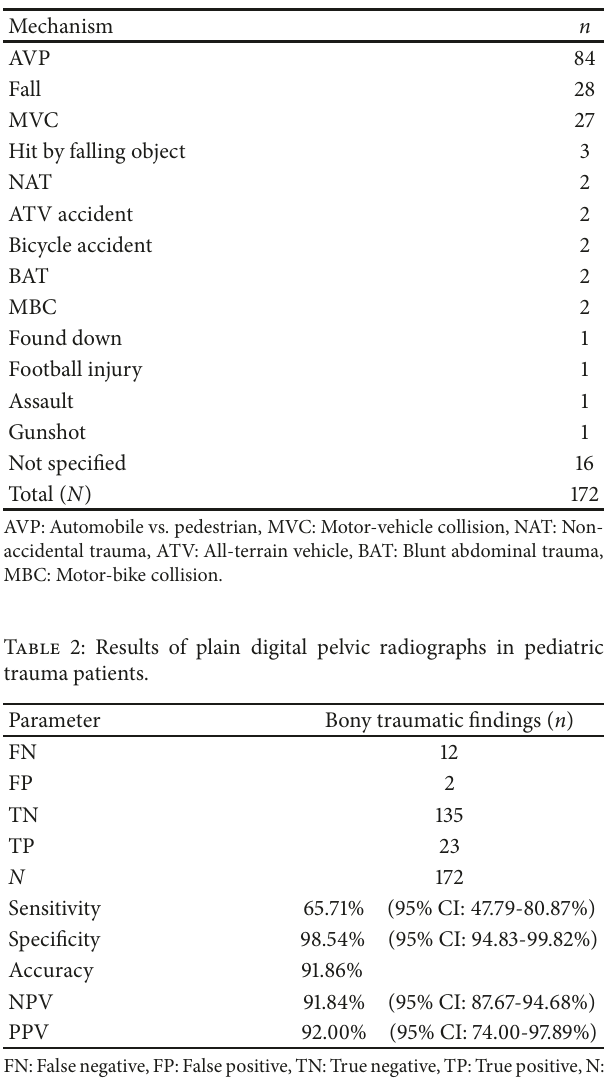
Table 1: Mechanism of injury in pediatric trauma patients.